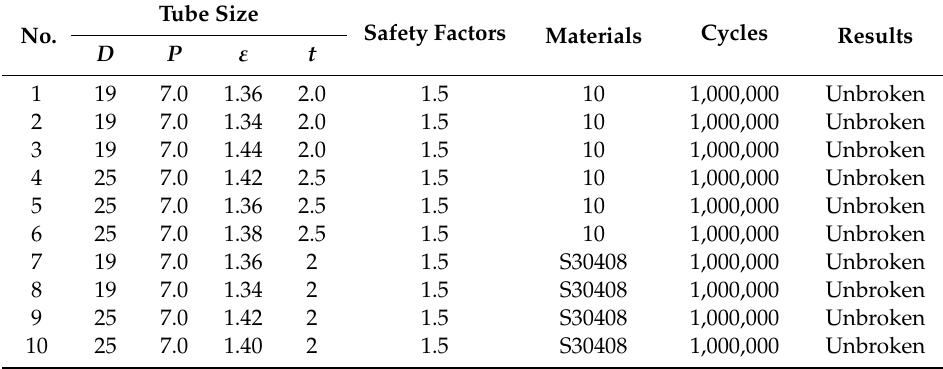
Table 3. Fatigue experimental results of the SG tubes with di ff erent sizes and materials.